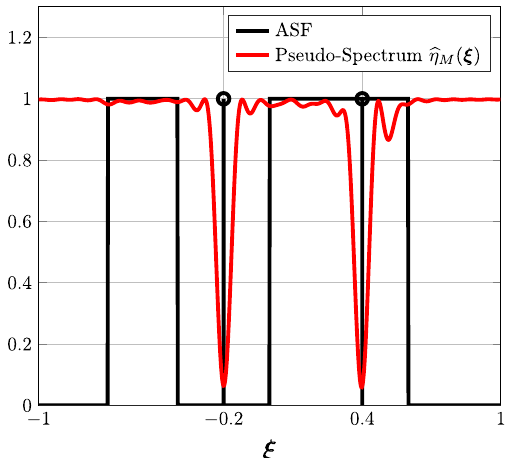
Fig. 4 The pseudo-spectrum plotted for the example ASF in (20) with M = 25 and N / M =